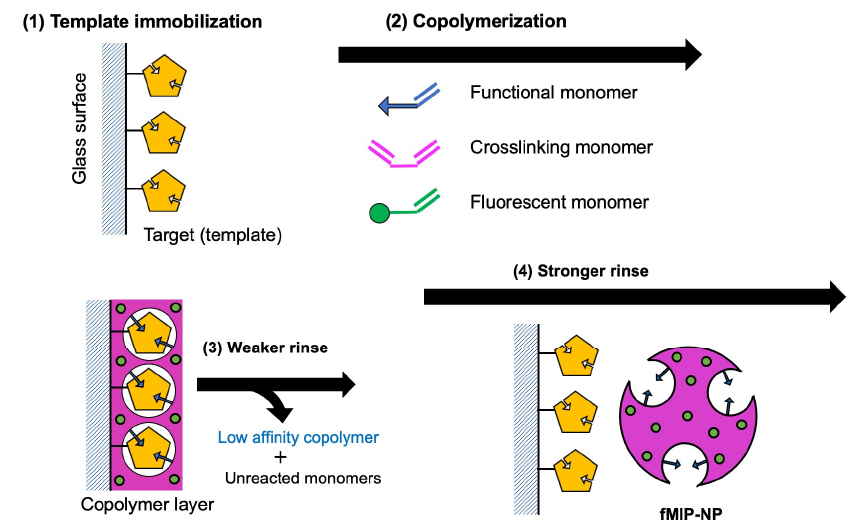
Figure 1. Scheme of the procedure for fMIP synthesis: (1) the target molecule was immobilized on the surface of glass as a template of the MIP, (2) functional monomer, crosslinking monomer, and fluorescent monomer were copolymerized at the vicinity of the surface, (3) copolymer which has low affinity with the template and unreacted monomers was removed by the weaker rinse, and (4) fMIP-NP which has high affinity with the template was dissociated from the surface by the stronger rinse.